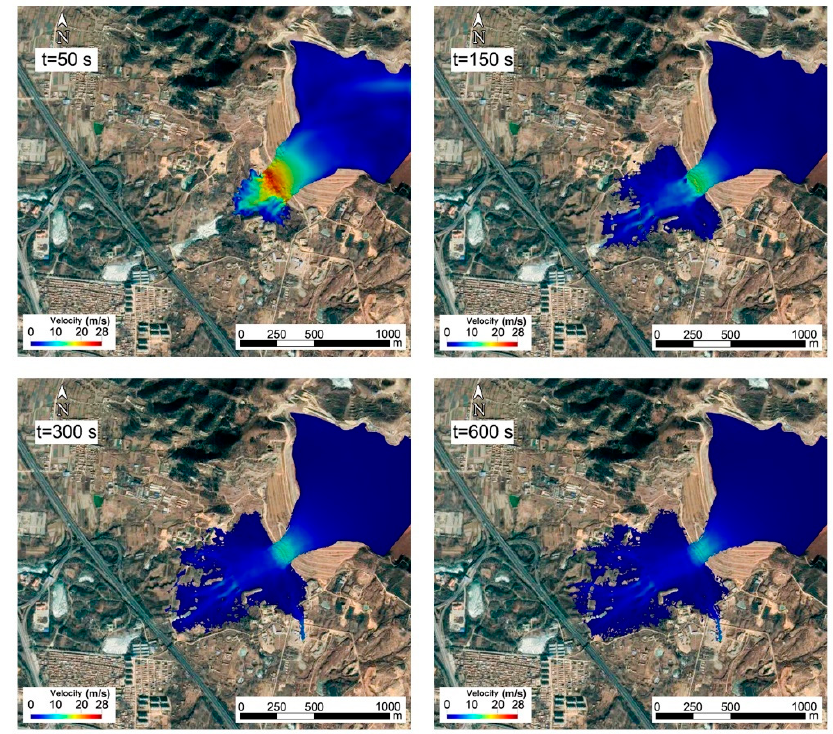
Figure 7. SPH numerical results of Yujiaquan tailings dam breach overland flow routings.